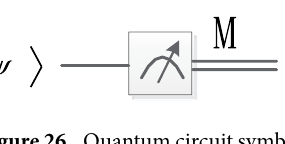
Figure 26. Quantum circuit symbol for measurement.